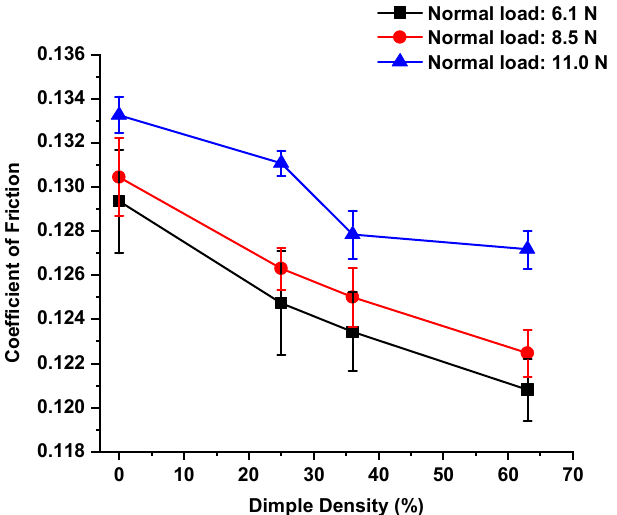
Figure 5. Comparison of CoFs in the non-textured case and textured cases under lubricated conditions and normal loads 6.1 N, 8.5 N, and 11.0 N.